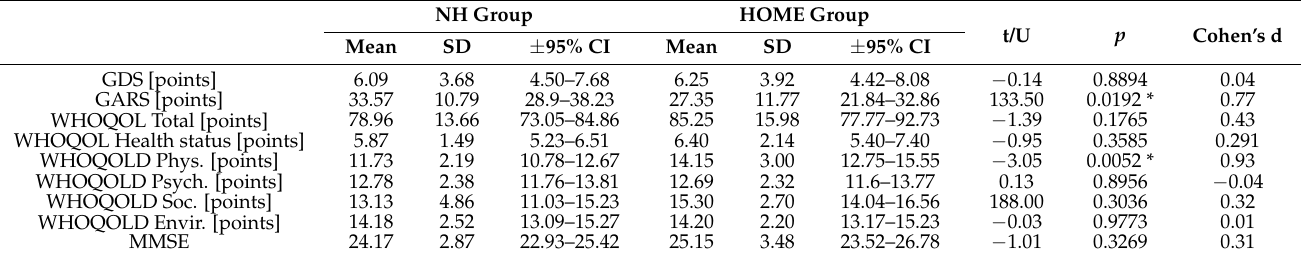
Table 3. Psychophysical self-assessment of the